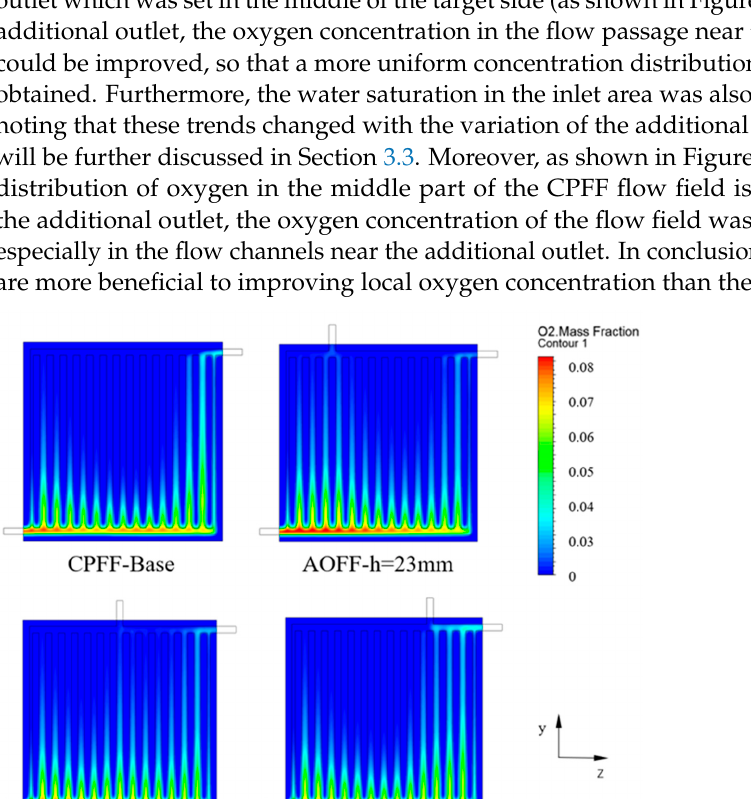
Figure 7. Water saturation on the cathode CL–GDL interface for the CPFF pattern and AOFF pat ‐ terns at Vcell = 0.5 V.